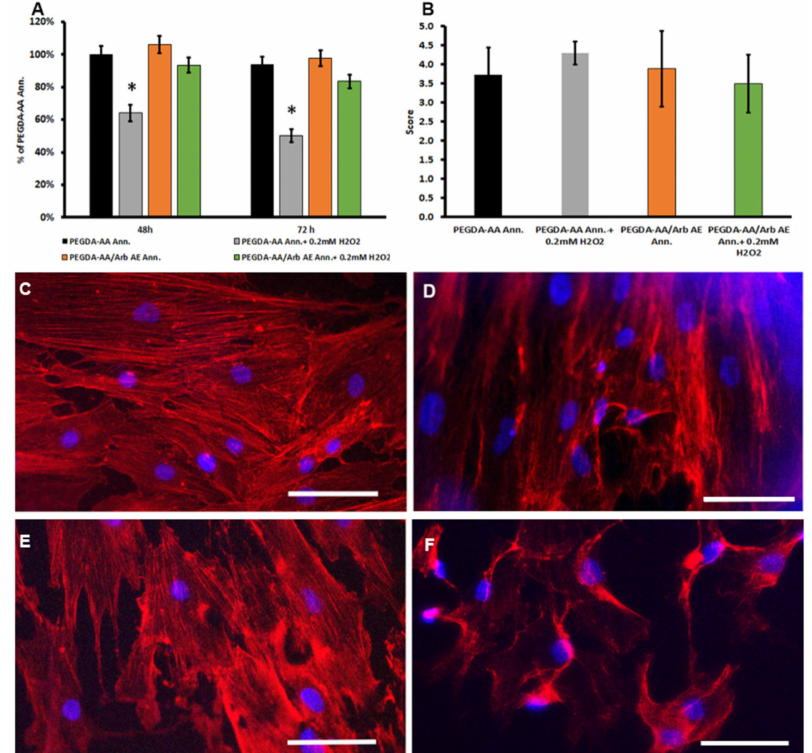
Figure 7. ( A ) MTT viability test in PDPCs cultured on PEGDA-AA Ann. and PEGDA-AA / Arb AE Ann. and exposed to oxidative stress. Data are expressed as a percentage of PDPCs cultured on PEGDA-AA Ann. 48 h = 24 h after stress induction, 72 h = 48 h after stress induction, * p < 0.05 vs. PEGDA-AA Ann. ( B ) Histogram depicts the semiquantitative analysis of the actin cytoskeleton. ( C – F ) Representative images of actin cytoskeleton immunofluorescence detection in PDPCs cultured on PEGDA-AA Ann. without ( C ) or with ( D ) oxidative stress, and PEGDA-AA / Arb AE Ann. without ( E ) or with ( F ) oxidative stress. Scale bars = 50 µ